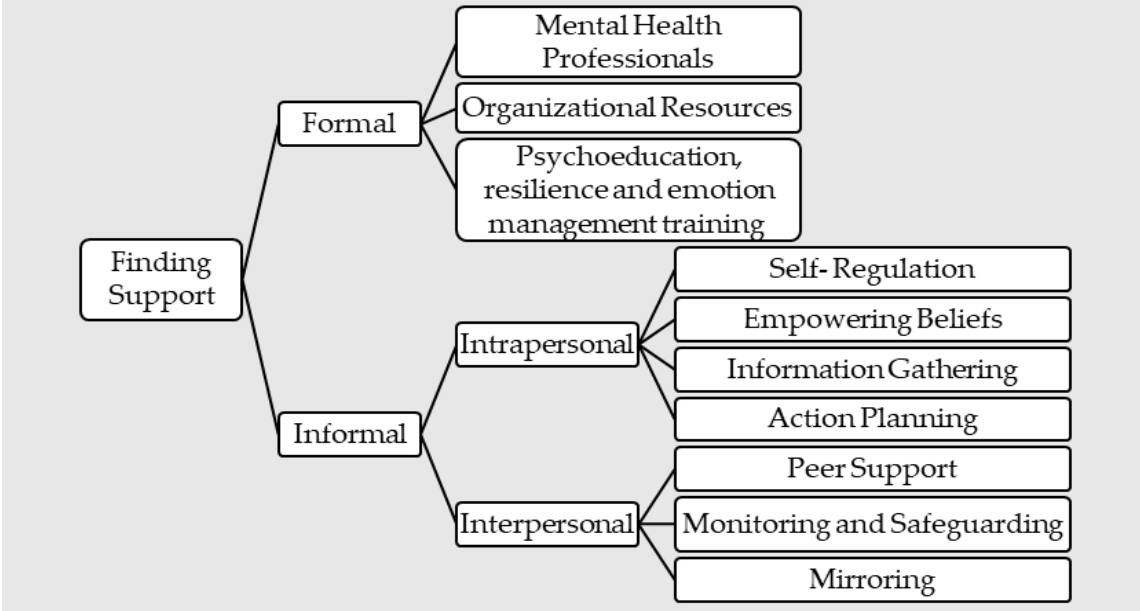
Figure 2. Summary of available support for trusted others.